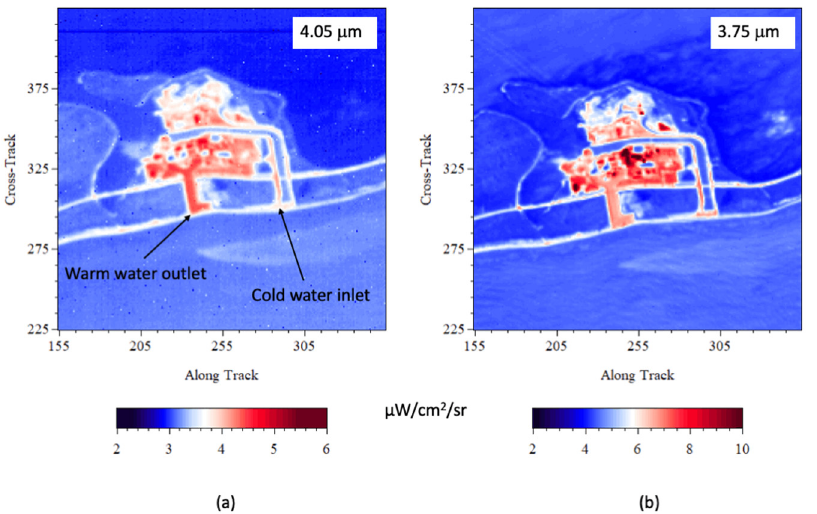
Figure 8. Calibrated radiance for Case N from the St. Lucie Nuclear Power Plant (27.35° N, 80.24° W) on the east coast of Florida during Science Flight #2 on 19 Jan 2021. Radiance from ( a ) 4.05 μ m, ( b ) 3.75 μ m (nadir) are presented. Notice the warm-water outlet and cold-water inlet flowing from and to the nuclear facility, respectively.